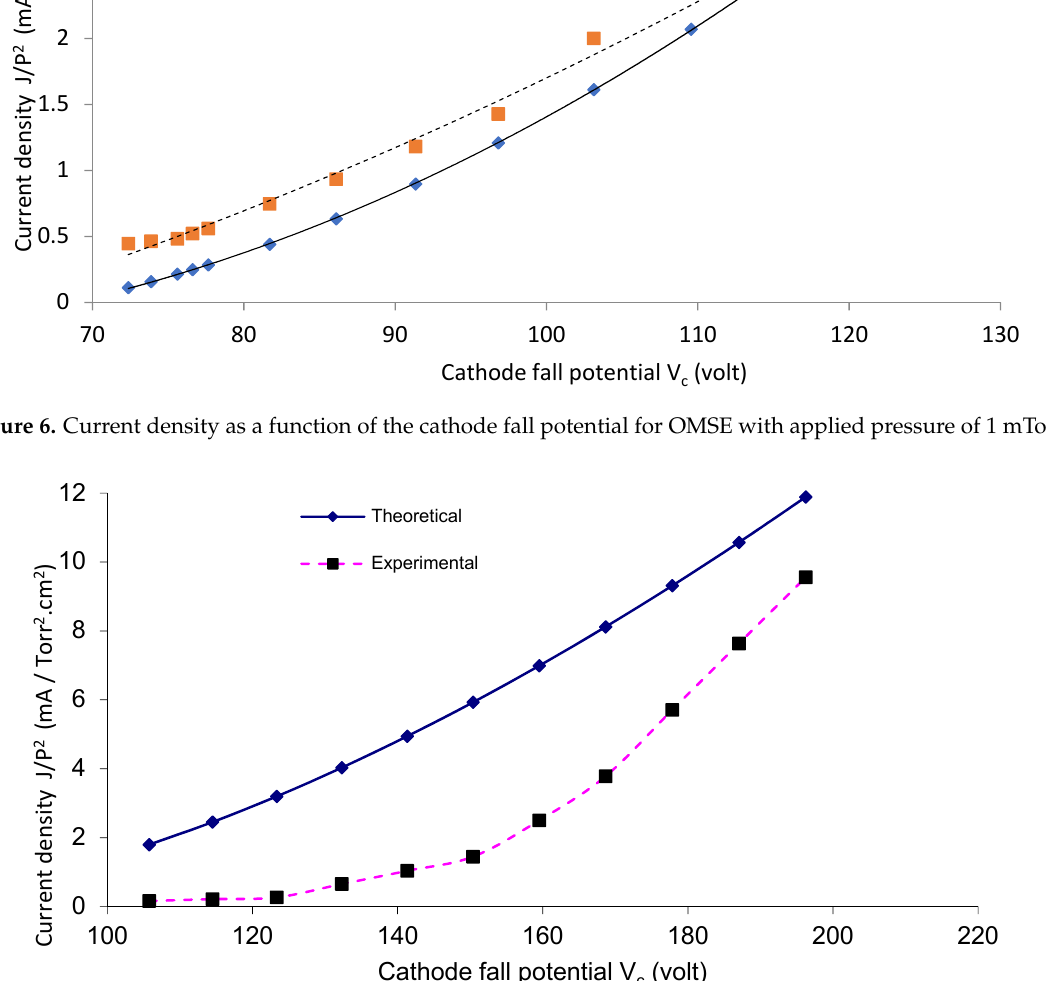
Figure 8. Current density as a function of the cathode fall thickness for OMSE with applied pressure of 1 mTorr.